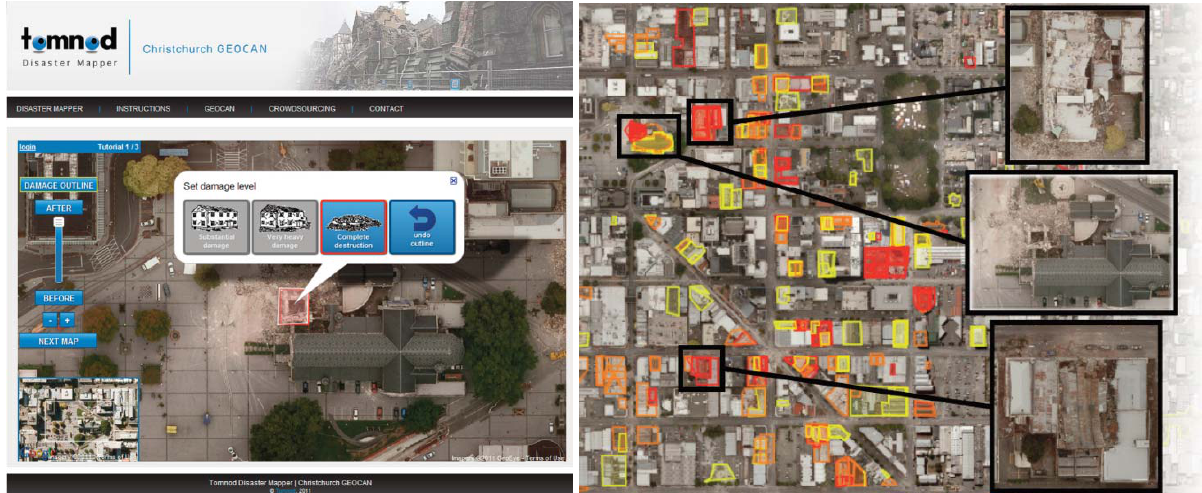
Figure 12: Christchurch earthquake survey. From at http://www.tomnod.com/geocan/. The training image on the left indicates how damage appears on photos. The yellow lines, drawn by the VGI community worldwide, outline serious earthquake damage to buildings in the image on the right.